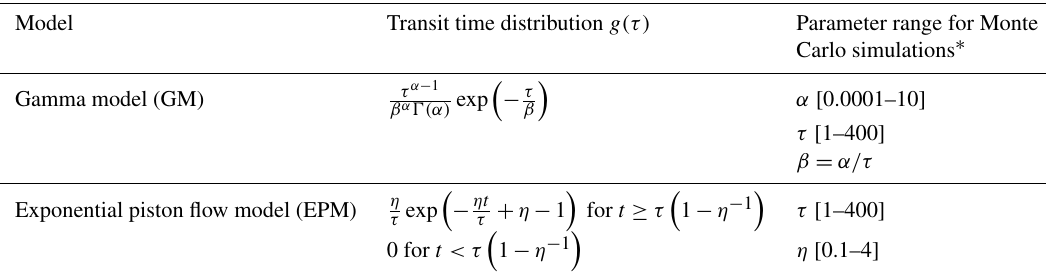
Table 2. The lumped parameter models used for the estimation of mean transit times in the South-West Mau,